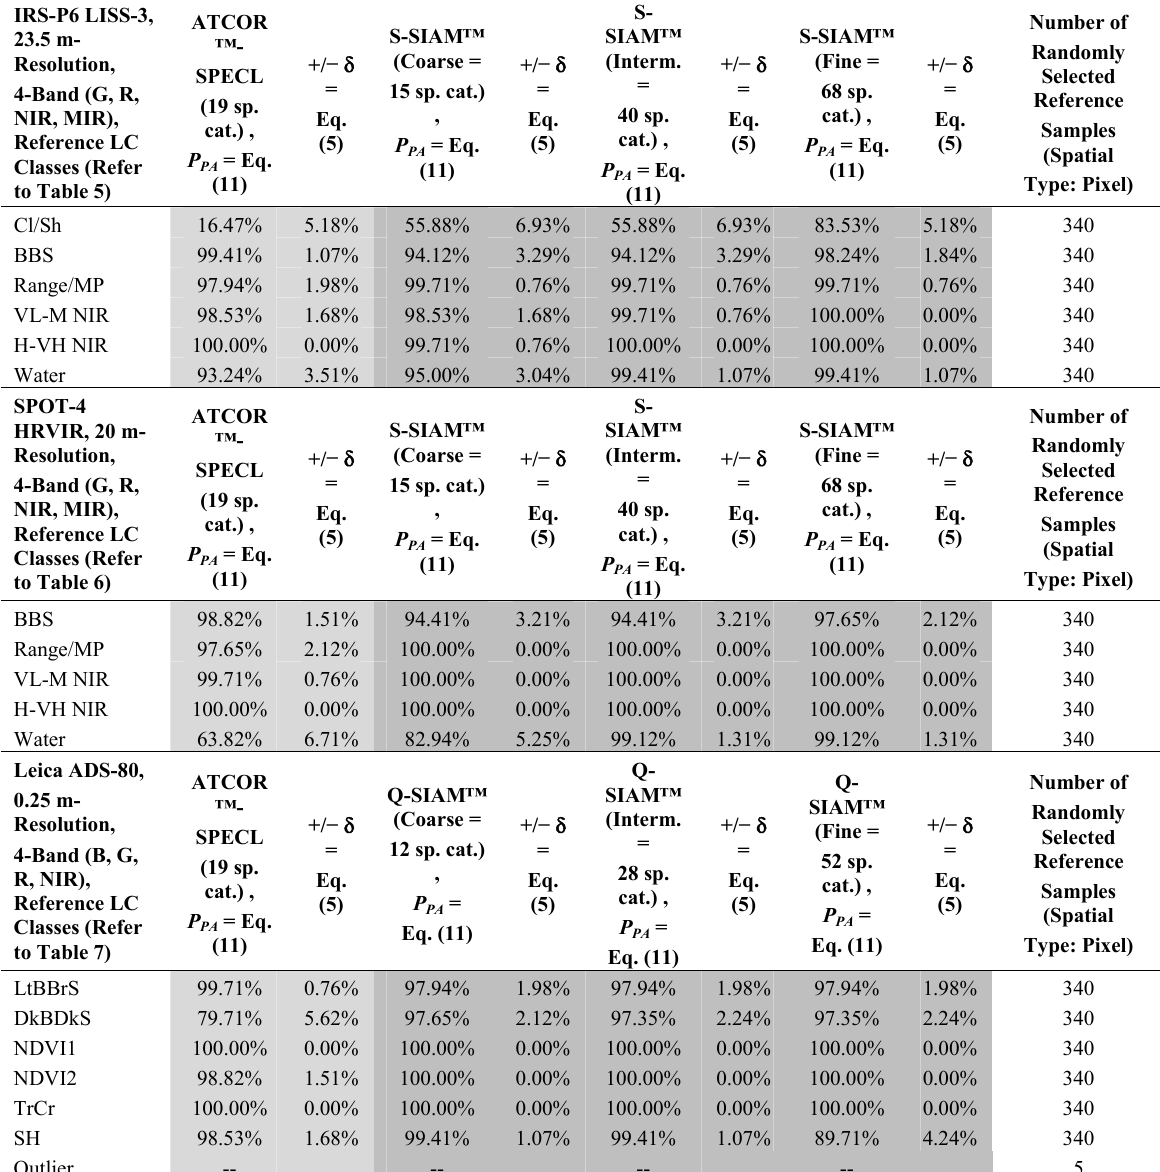
= Equation (11) ±δ = Equation (5) for the Table 16. Producer’s Accuracy = (cid:1868) (cid:3017)(cid:3002) ATCOR™-SPECL and SIAM™ pre-classifications of the three test images with α = RC